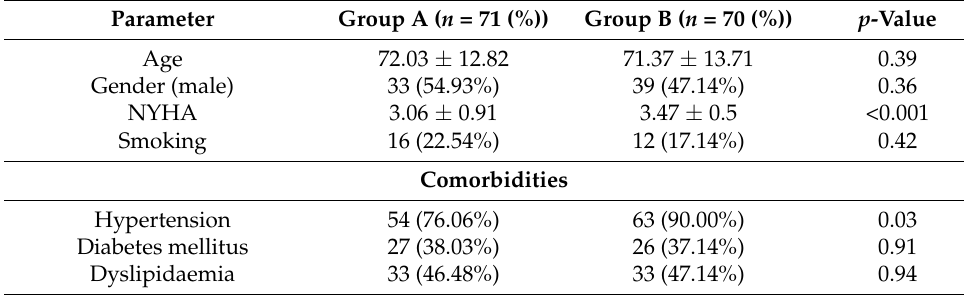
Table 1. Clinical, laboratory, and echocardiography characteristics of the study